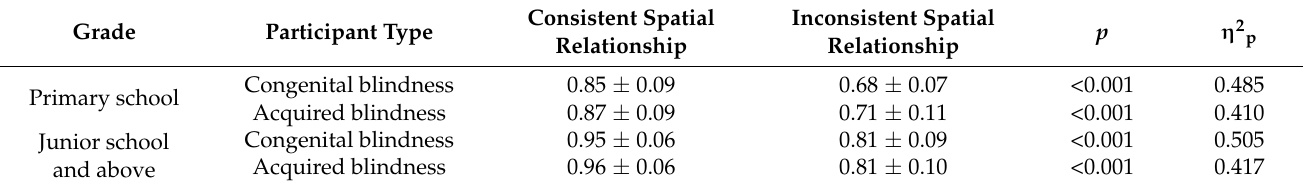
Table 1. Correct rate, significance and effect size of participants’ responses under different grades, participant types, and spatial location (M ±